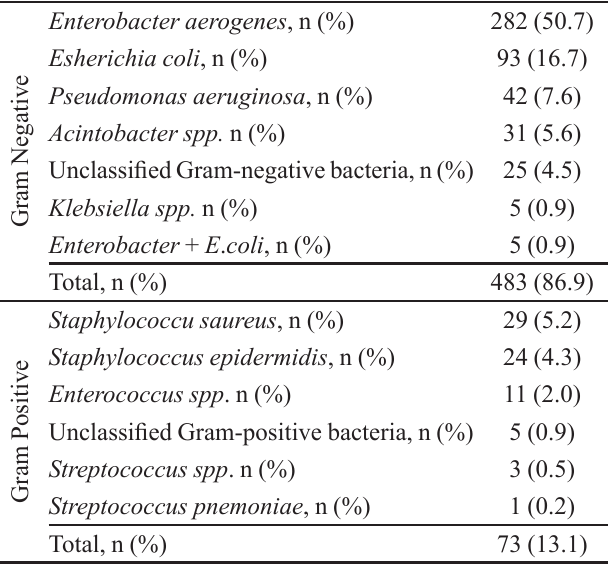
TABLE I - Bacterial typing of ordered cultures Bacterial